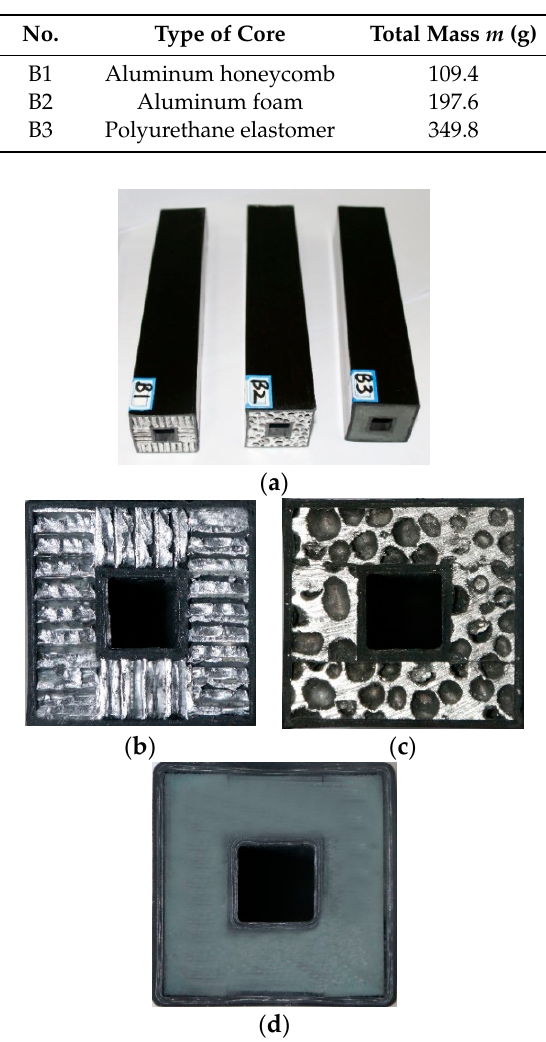
Table 1. The number and mass of the three di ff erent composite sandwich laminated box beams.